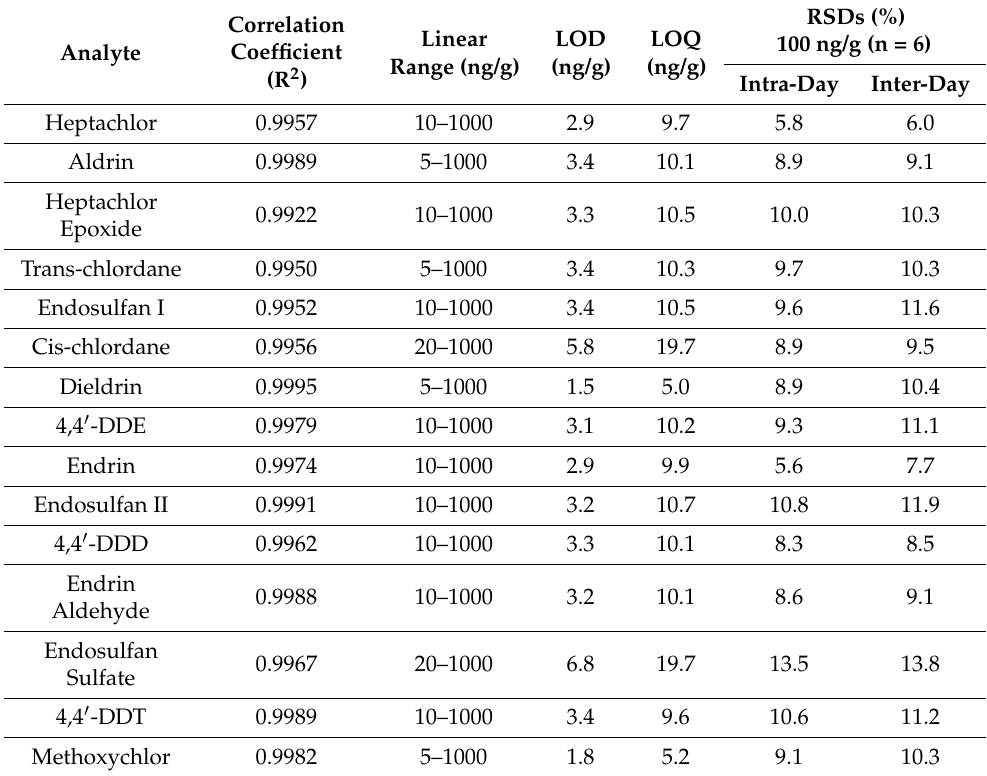
Table 4. Analytical figures of merit for the proposed